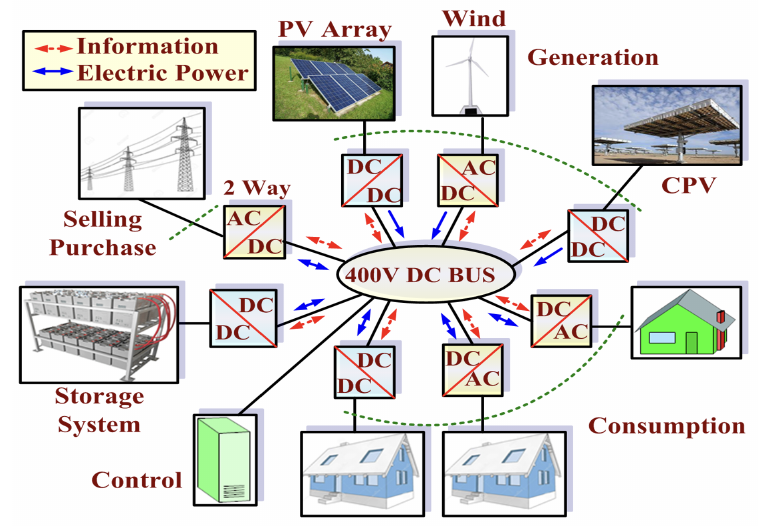
Figure 1. Typical microgrid structure with 400 V DC